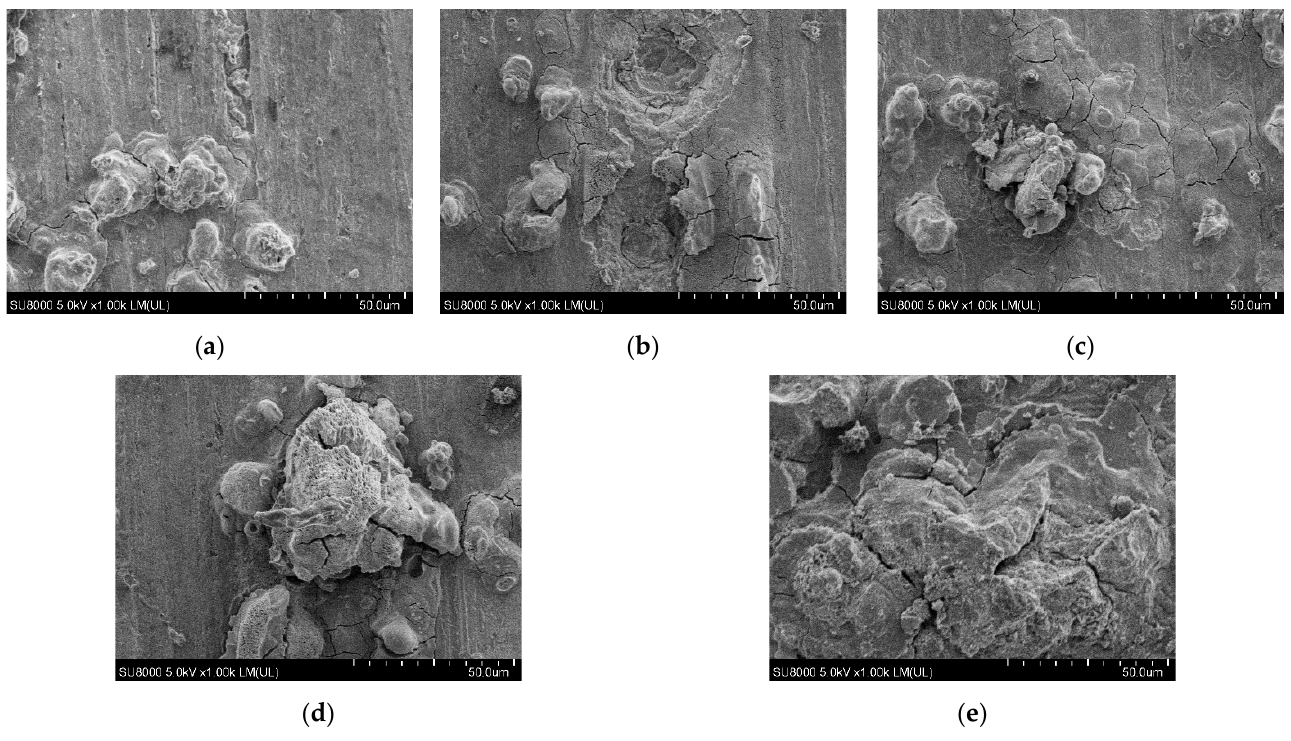
Figure 8. Microscopic corrosion morphology of hanging piece under different Ca 2+ + Mg 2+ content. ( a ) Ca 2+ + Mg 2+ content 7700 mg/L; ( b ) Ca 2+ + Mg 2+ content 9500 mg/L; ( c ) Ca 2+ + Mg 2+ content 11,000 mg/L; ( d ) Ca 2+ + Mg 2+ content 12,500 mg/L; ( e ) Ca 2+ + Mg 2+ content 14,000